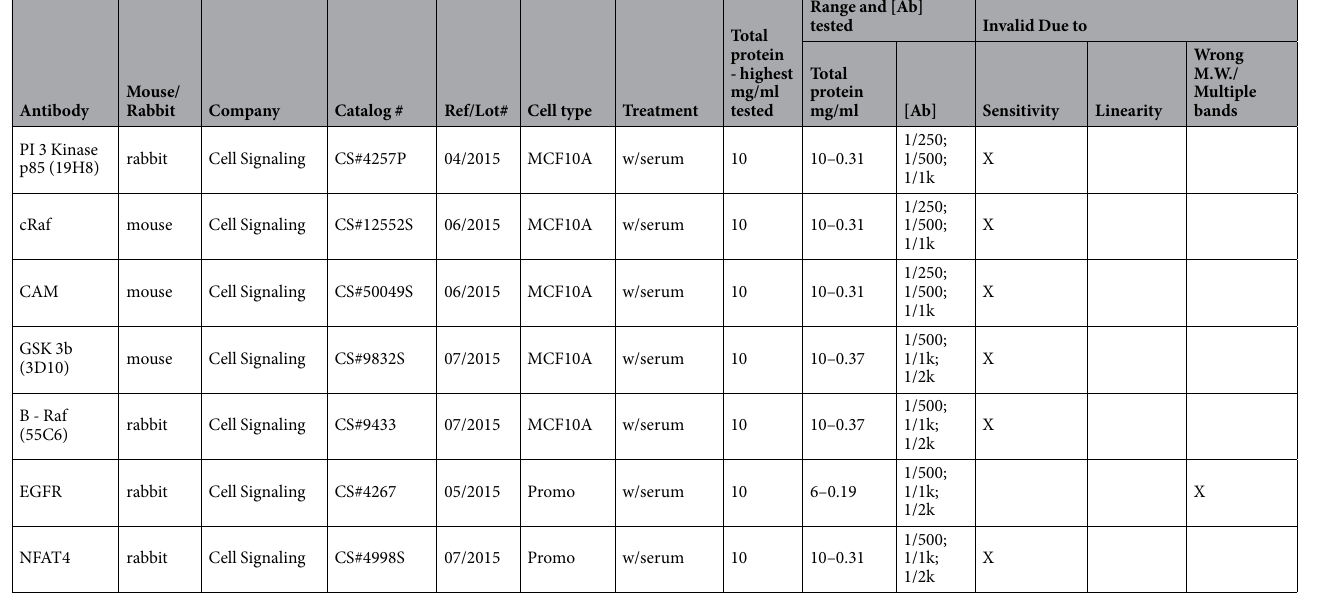
Table 2. Ab Validation for MWA - Invalid